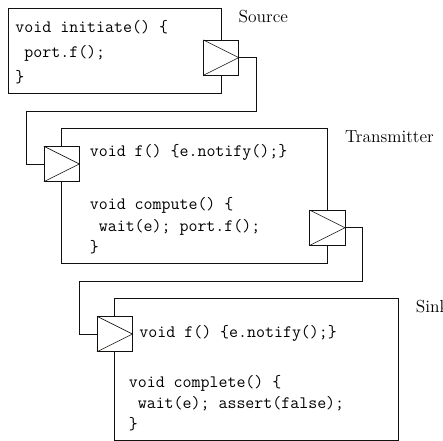
Figure 5 Source code of the chain benchmark for n =